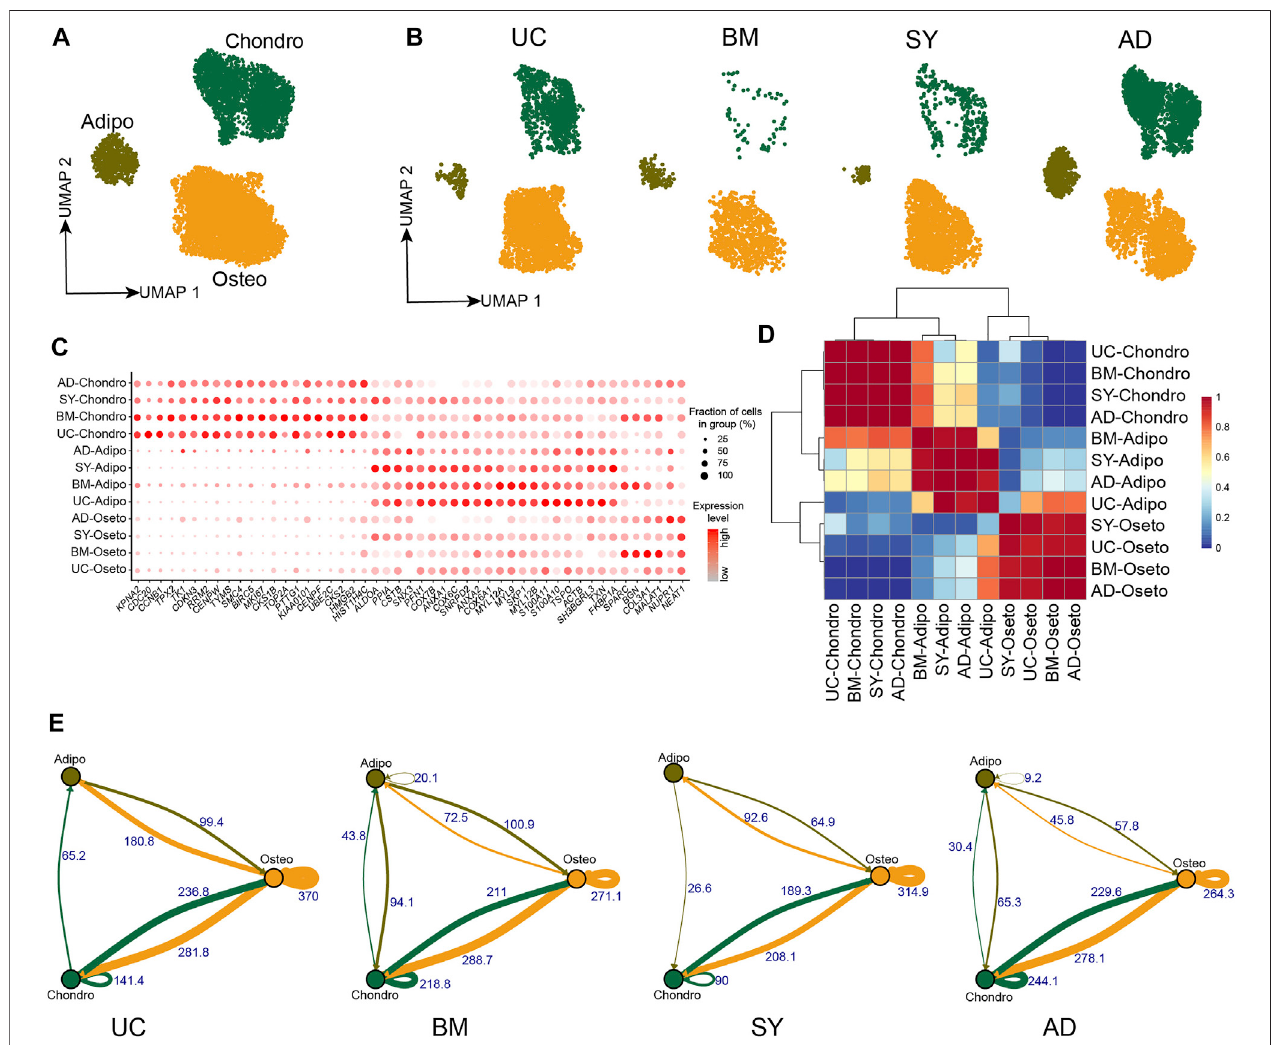
FIGURE1| MSCsubpopulationsin4differenttissues. (A) .UMAPprojectionofMSCsin4differenttissues,coloredbyMSCsubpopulations. (B) .UMAPprojection of MSCs from each tissue, namely UC-MSCs, BM-MSCs, SY-MSCs, and AD-MSCs. (C) . Dot plot of the expression of subpopulation-speci fi c genes in the MSC subpopulations. (D) . Heatmap of AUROC scores between MSC subpopulations pairs, in which AUROC scores represent similarities between subpopulations. (E) . Weighted ligand-receptor interactions between MSC subpopulations pairs in each tissue based on STRING database. The edge thickness and corresponding numbers indicate the sum of weighted paths between